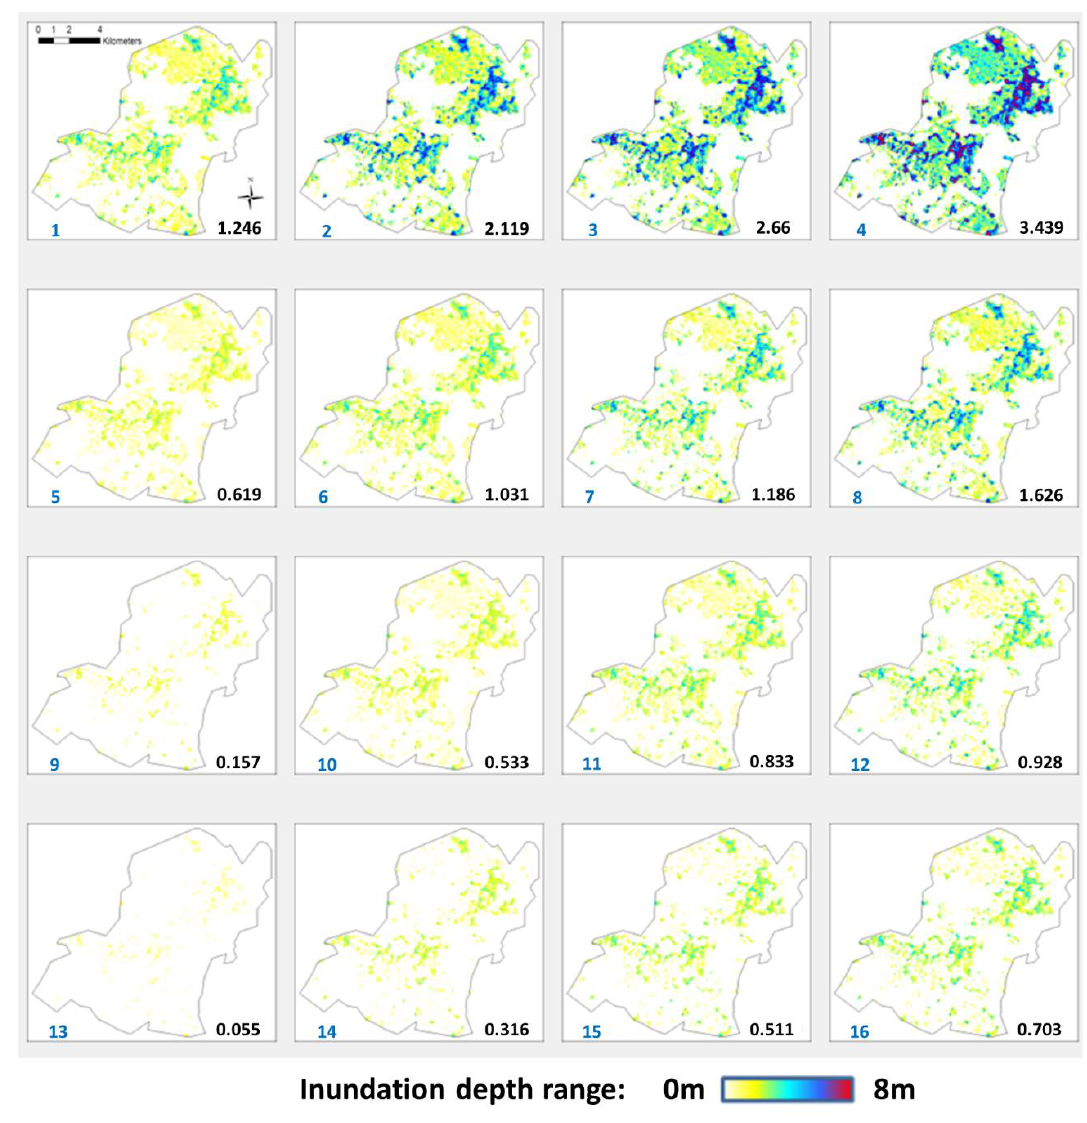
Figure 7. Topology of 4 × 4 clustering maps.